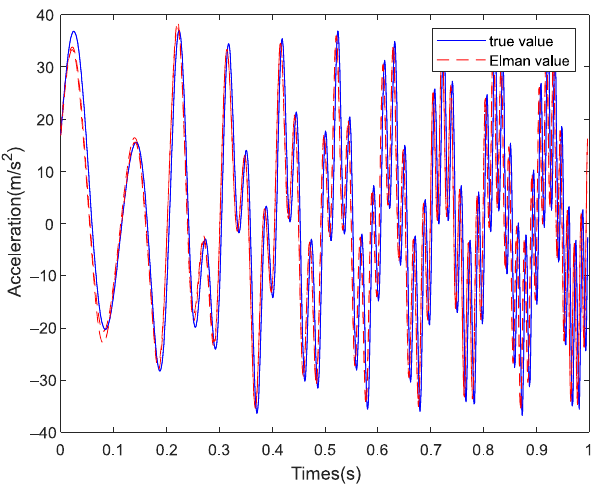
Figure 10. Reconstruction results after IEMD decomposition.